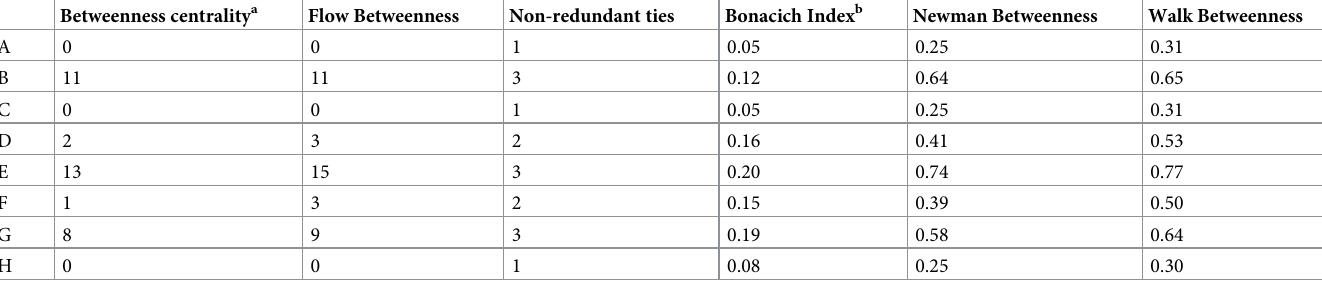
Table 1. Comparison of the measures of bridging positions of nodes in a hypothetical network in Fig 1. Betweenness centrality